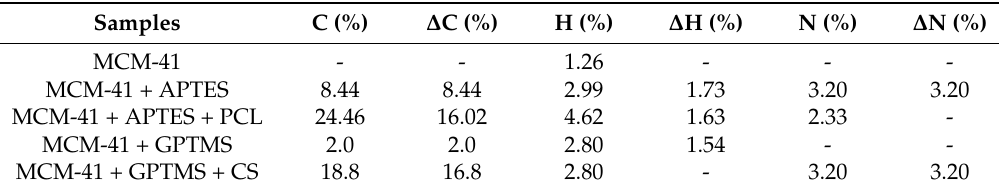
Table 3. Elemental analysis of MCM-41 and its modified surface